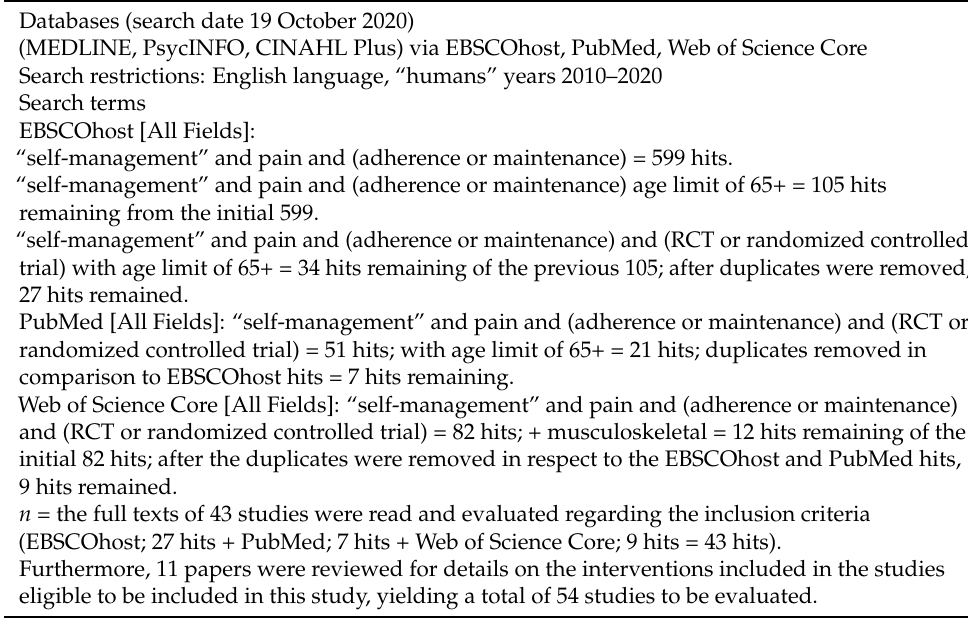
Table 1. Search strategy for adherence to and the maintenance of pain self-management programmes in older adults with musculoskeletal pain who were included in randomized controlled